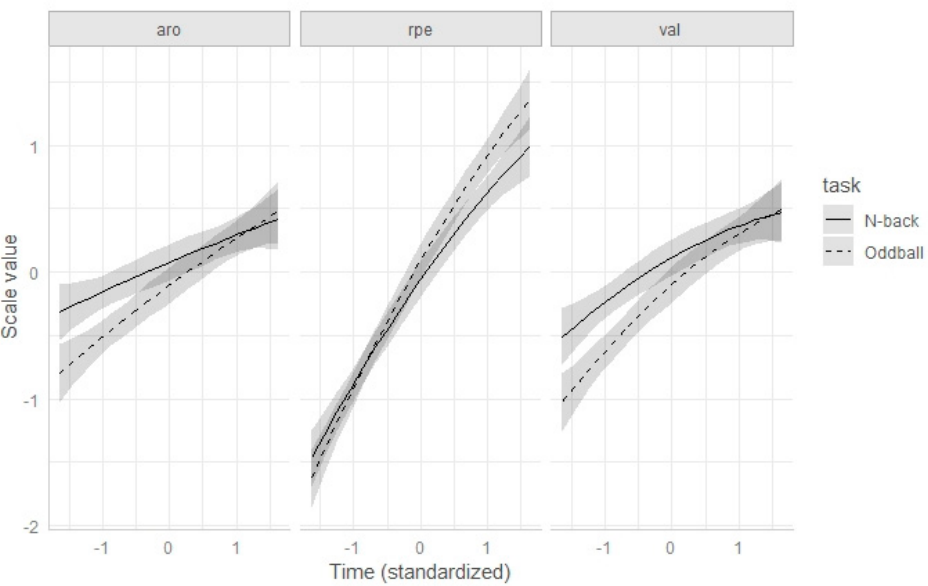
Figure A3. Predicted values from the best-fitting model for subjective scales (arousal, valence, and RPE) with no internal physical load covariates.